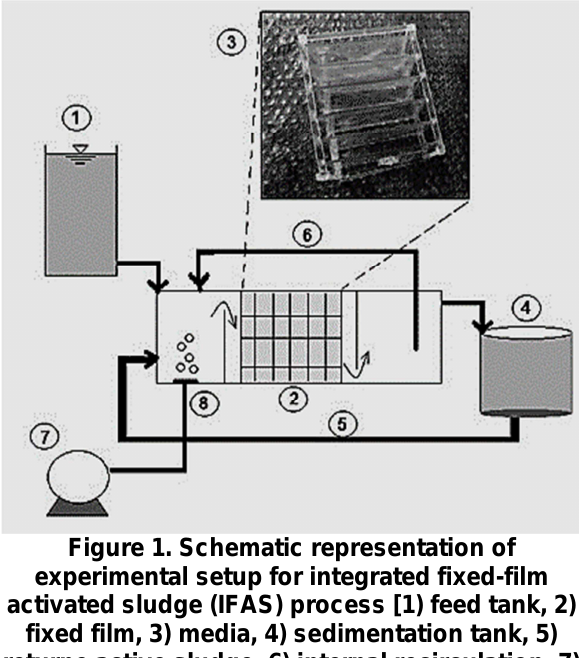
Figure 1. Schematic representation of experimental setup for integrated fixed-film activated sludge (IFAS) process [1) feed tank, 2) fixed film, 3) media, 4) sedimentation tank, 5) returne active sludge, 6) internal recirculation, 7) blower, 8) air